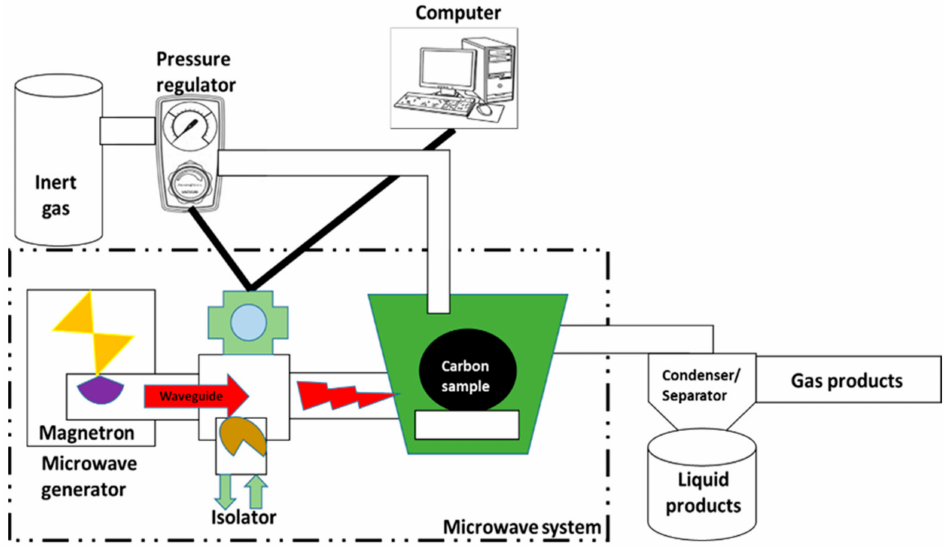
Figure 6. Microwave experimental setup for AC